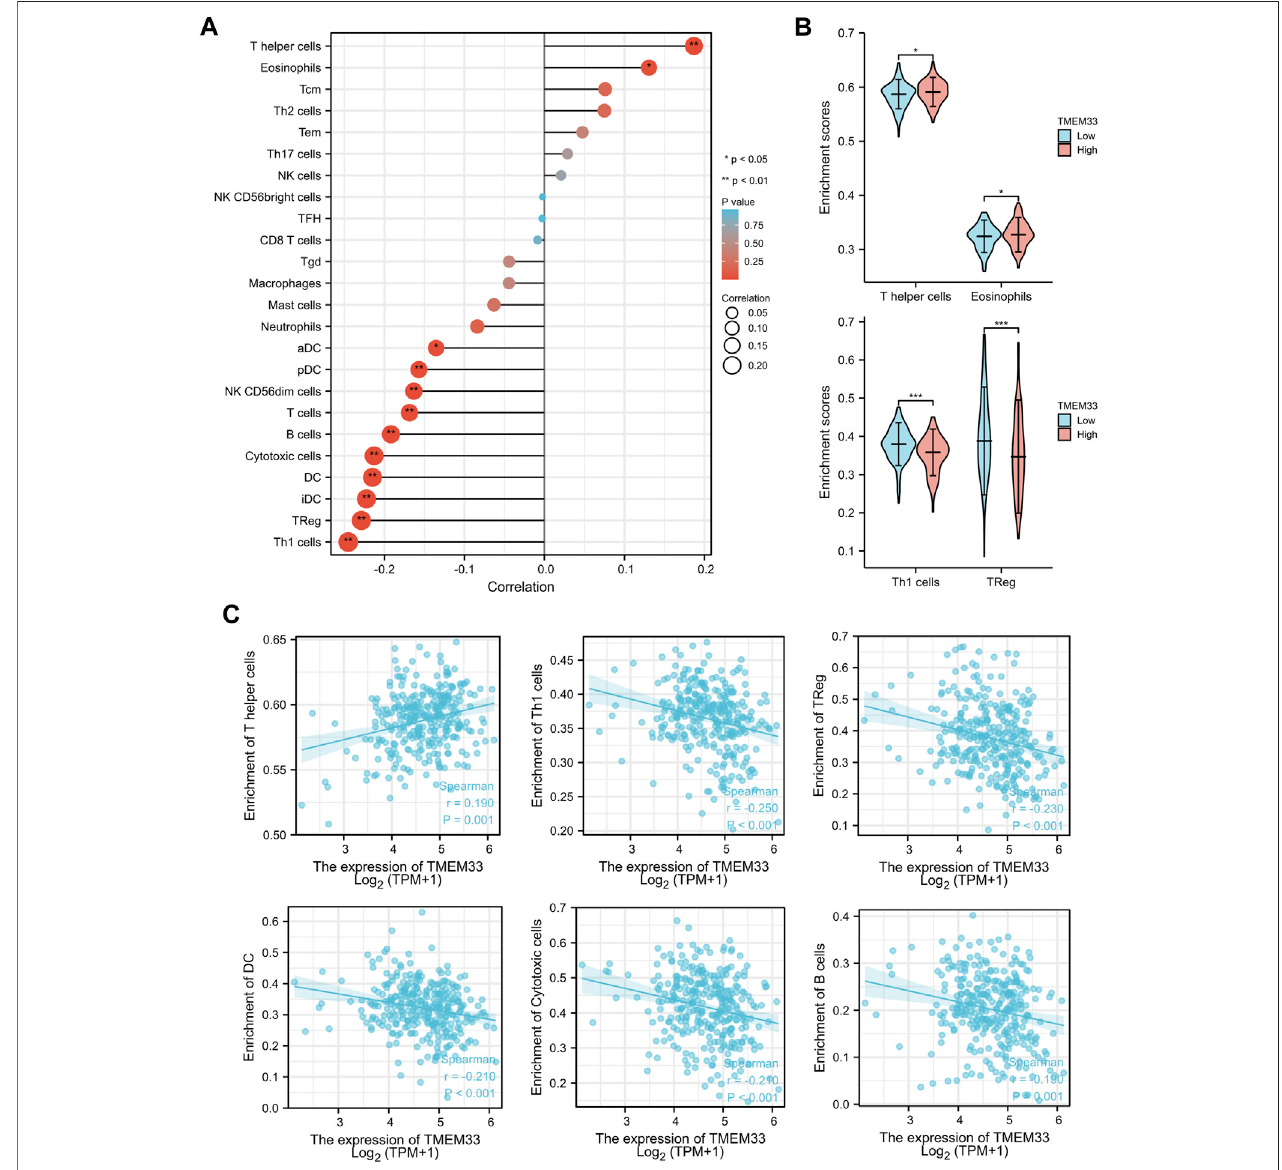
FIGURE 4 | Immune in fi ltration analysis of TMEM33 in CESCC. (A) The forest plot shows the correlation between TMEM33 expression level and 24 immune cells. (B) The enrichment scores of TMEM33 expression in T helper cells, Eosinophils, Th1 cells, and TReg. (C) The correlation between TMEM33 expression and T helper cells, Th1 cells, TReg, DC, Cytotoxic cells, and B cells. * p < 0.05, ** p < 0.01, and *** p <